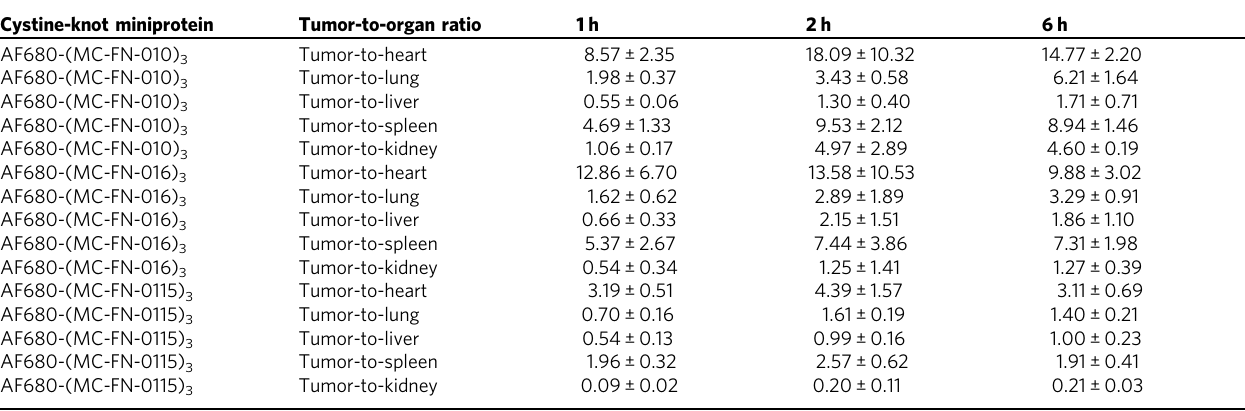
Table 2 Biodistribution of cystine-knot miniproteins in human U-87 MG xenograft mouse tumors. Cystine-knot